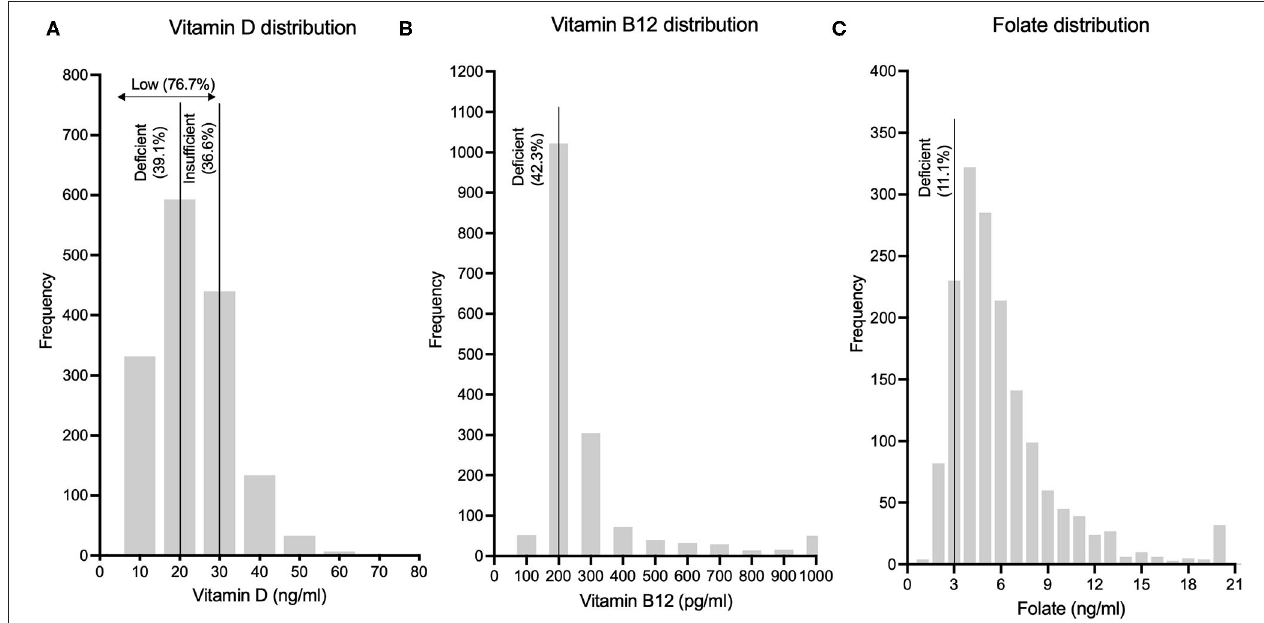
FIGURE 1 | Frequency distributions of (A) Vitamin D levels, (B) Vitamin B12 levels and (C) Folic acid levels in this rural Indian population are depicted.